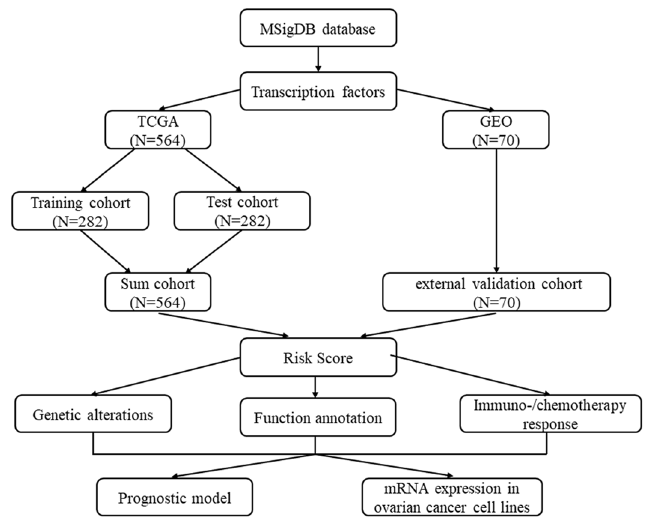
Figure 1. The workflow of this